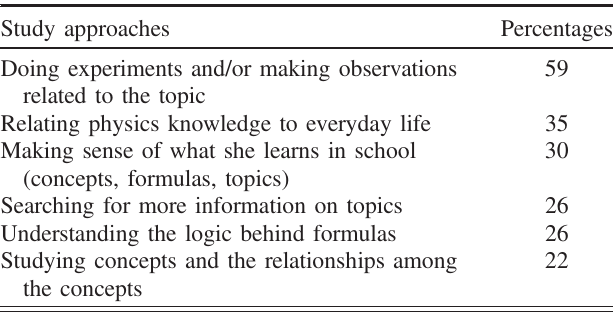
TABLE III. Coding categories for students ’ responses to “ how should Arzu study physics? ”